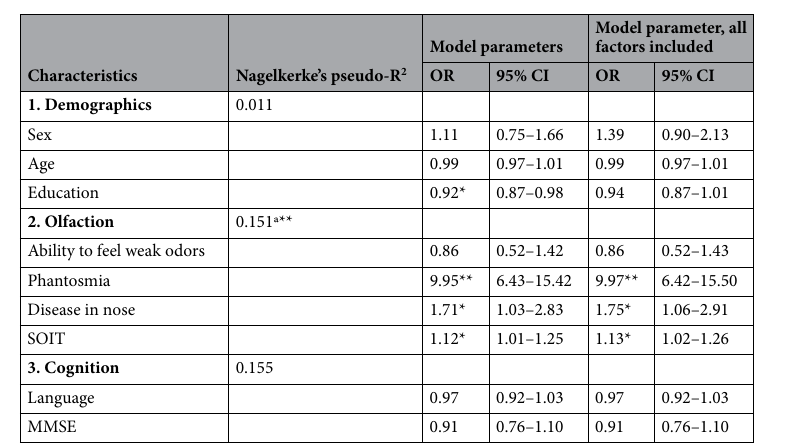
Table 2. Block wise hierarchical logistic regression analysis for correlates of parosmia. MMSE mini-mental state examination, SOIT , Scandinavian odor-identification test, OR odds ratio, 95% CI 95% confidence